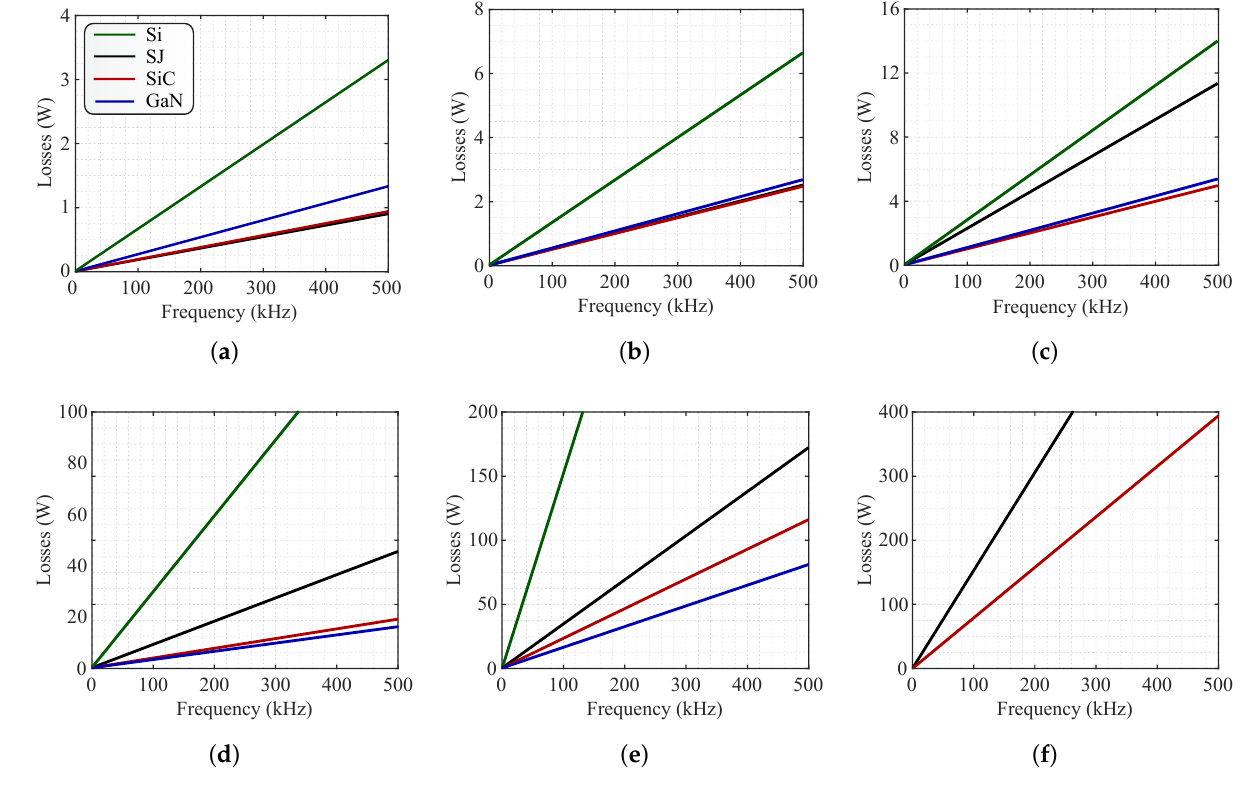
Figure 7. Switching losses: ( a ) 2.5 A, ( b ) 5 A, ( c ) 10 A, ( d ) 20 A, ( e ) 40 A and ( f ) 80 A.